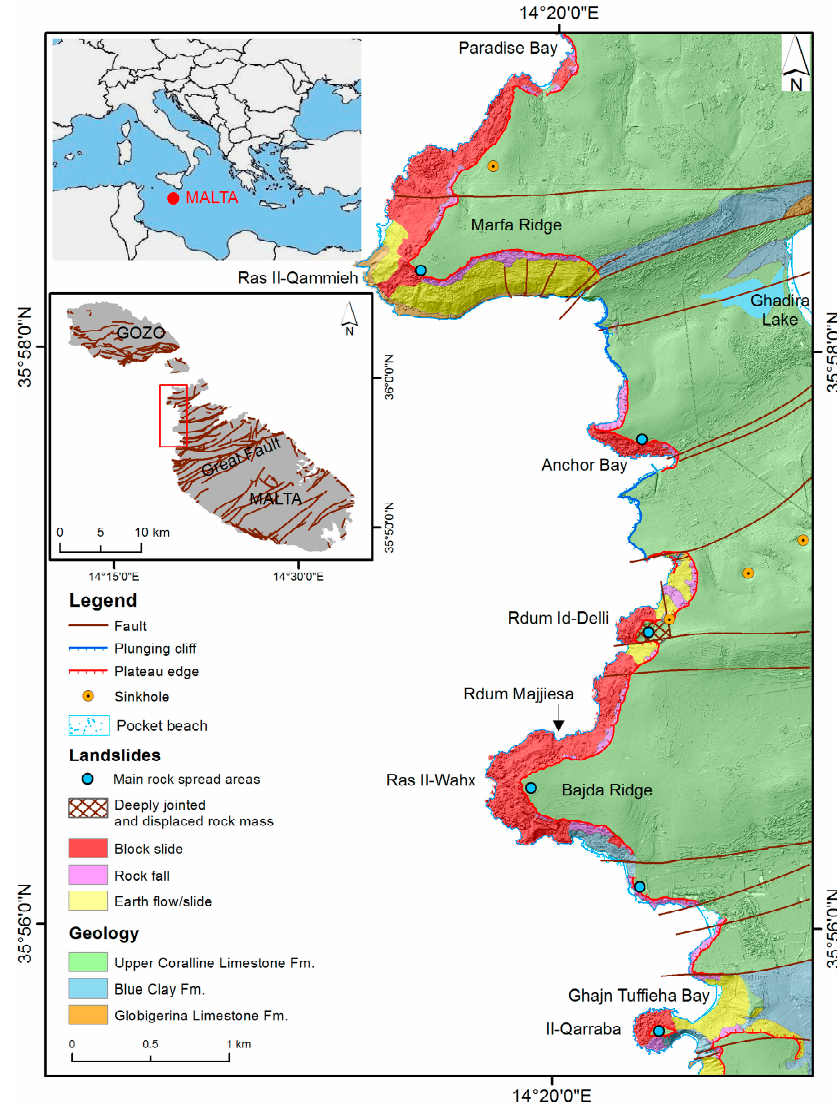
Figure 1. Geological and geomorphological setting of the study area.